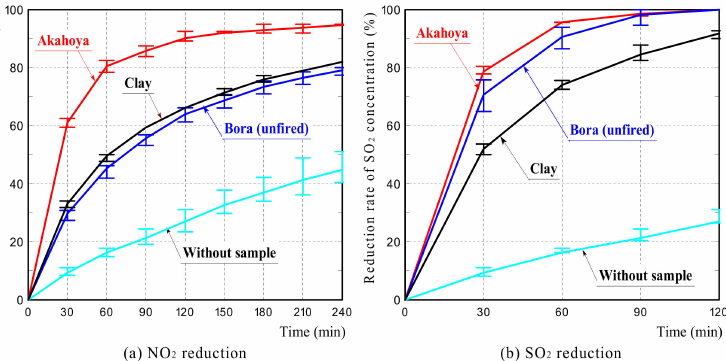
Figure 15. Reduction rates of the ( a ) NO 2 and ( b ) SO 2 concentrations with the samples.